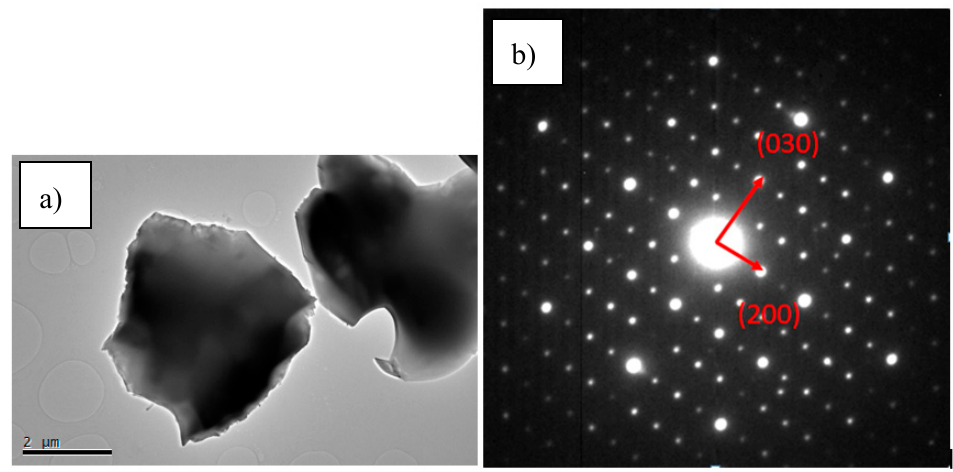
Figure 5. Raman spectra of the obtained Al-1 3S powders excited by a 633 He–Ne laser.